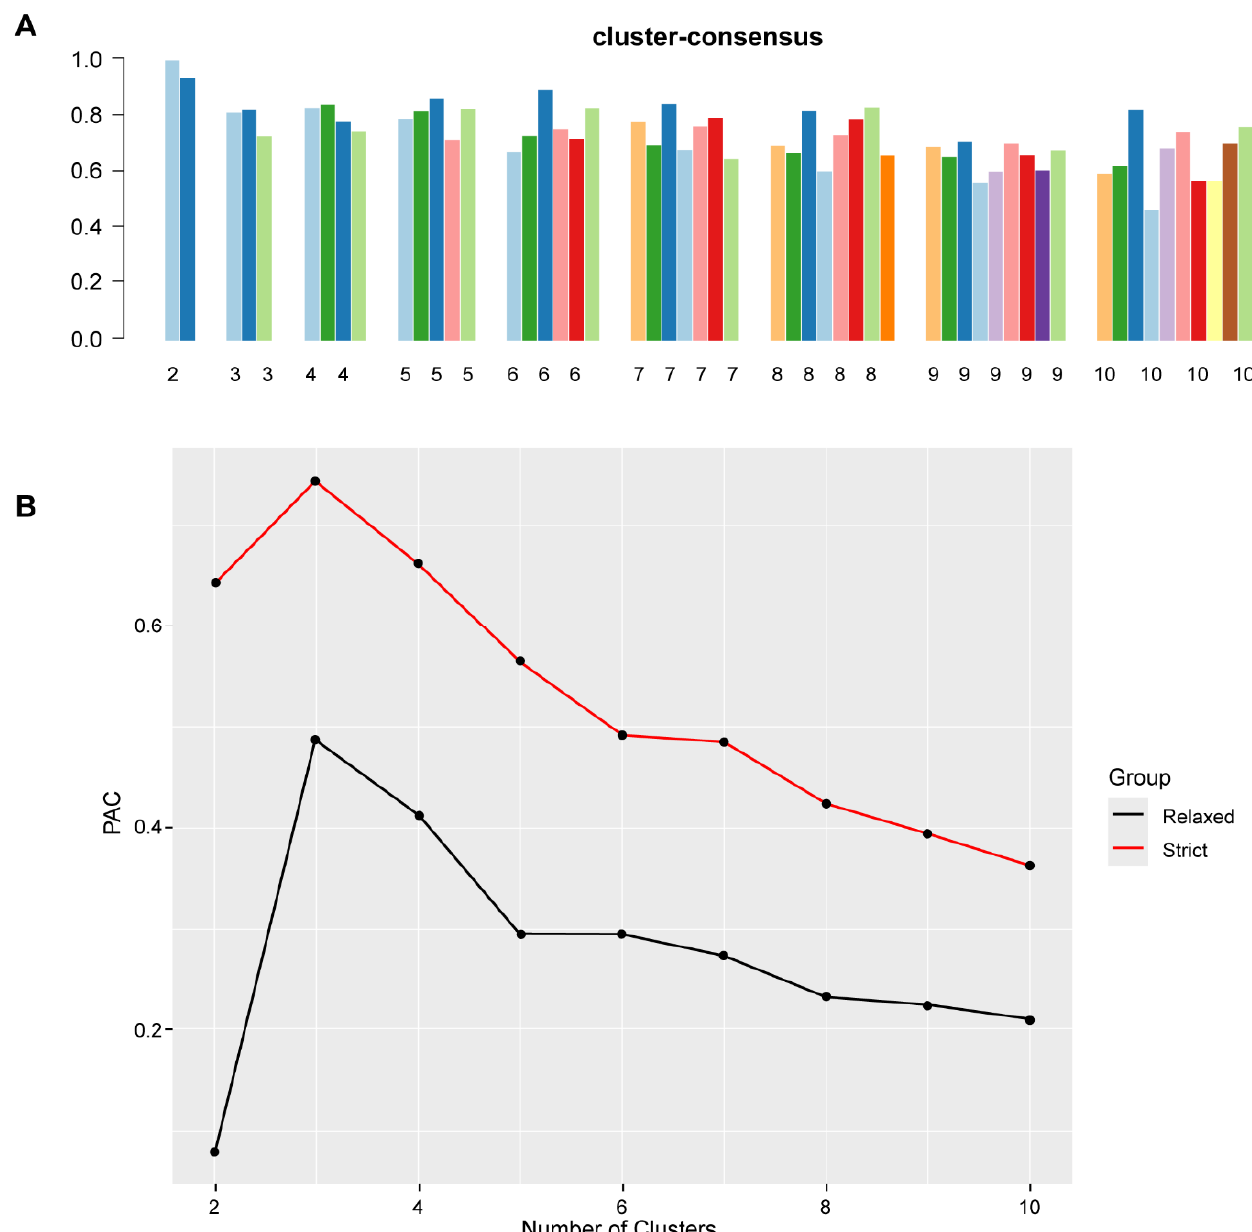
Figure 2. ( A ) The bar plot represents the mean consensus score for different numbers of clusters (K ranges from two to ten). ( B ) The PAC values assess ambiguously clustered pairs.